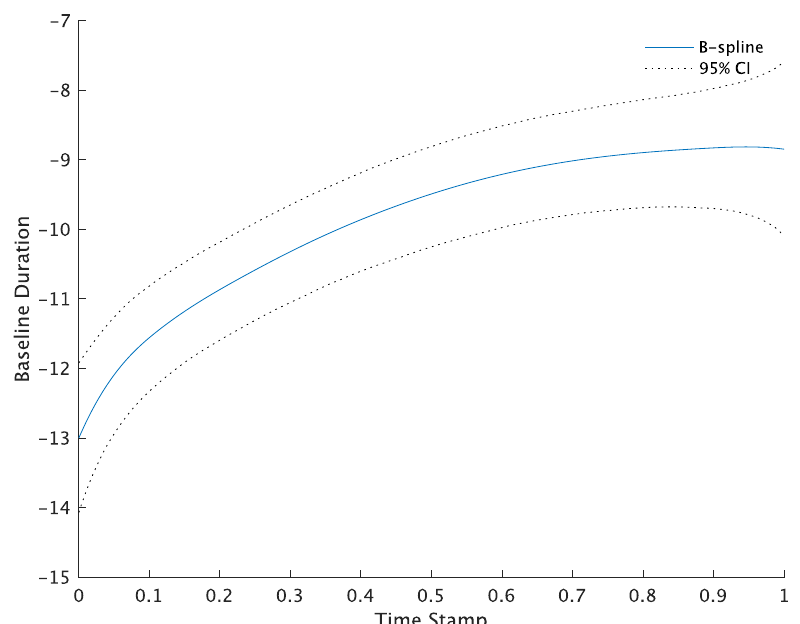
Figure 5. Intraday seasonality of time interval of AGH, Tokyo, Japan (23 June